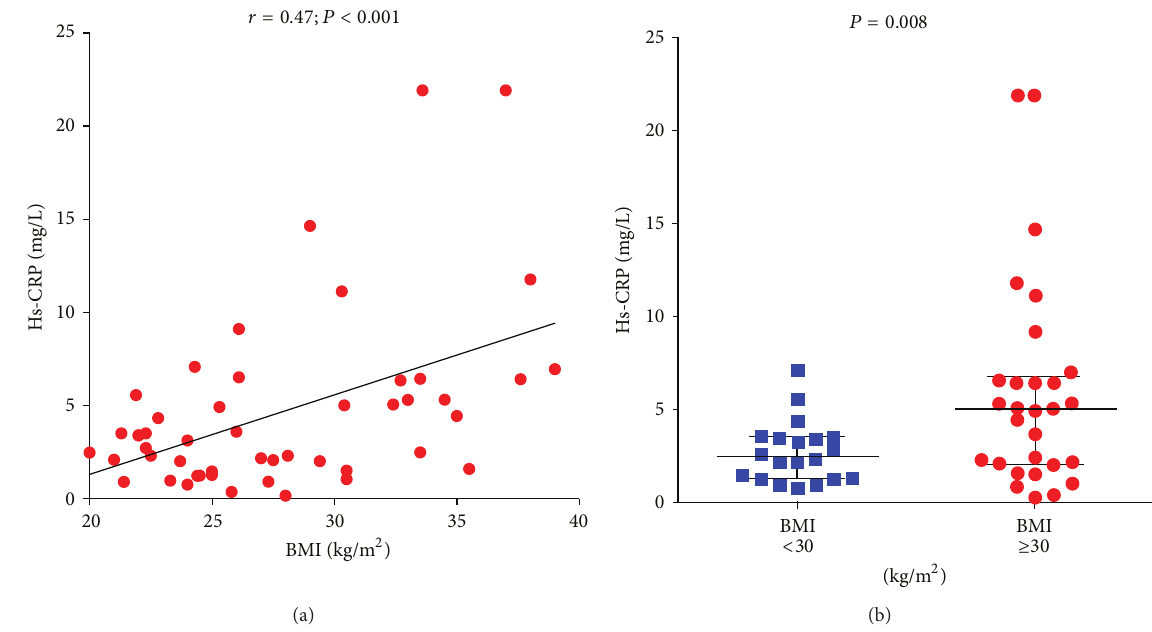
Figure7:Correlationbetweenserumhs-CRPlevelsandBMIinT2DMpatients.T2DMpatientsweredefinedasinFigure1.Dataarepresented assingledatapoints.(a)Positivecorrelationwasstatisticallyfoundbetweenserumhs-CRPlevelsandBMIinT2DMpatients.(b)ObeseT2DM patients (BMI ≥ 30 kg/m 2 ) showed higher levels of serum hs-CRP than nonobese (BMI < 30kg/m 2 ) T2DM